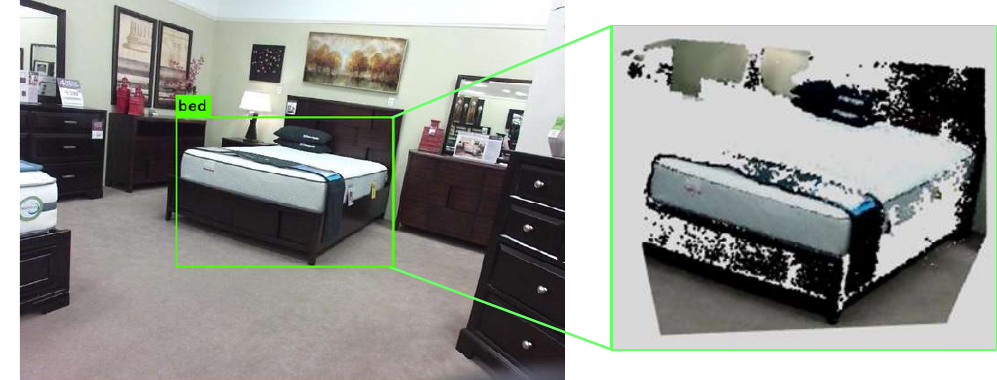
Figure 1. Object point cloud extraction of an image from the SUN RGB-D dataset. Object detection is conducted by YOLO V3 and an object point cloud is extracted by utilizing RGB and depth images. There are many points missing in the object point cloud.